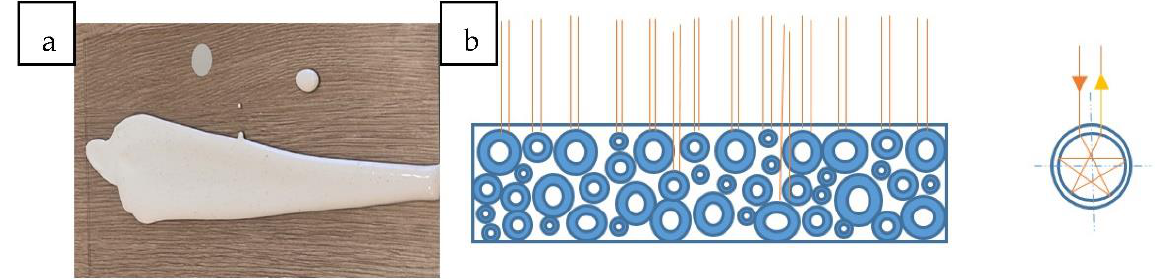
Figure 1. ( a ) Photo of the white paint; ( b ) Reflective paint layer, “trap” microsphere.